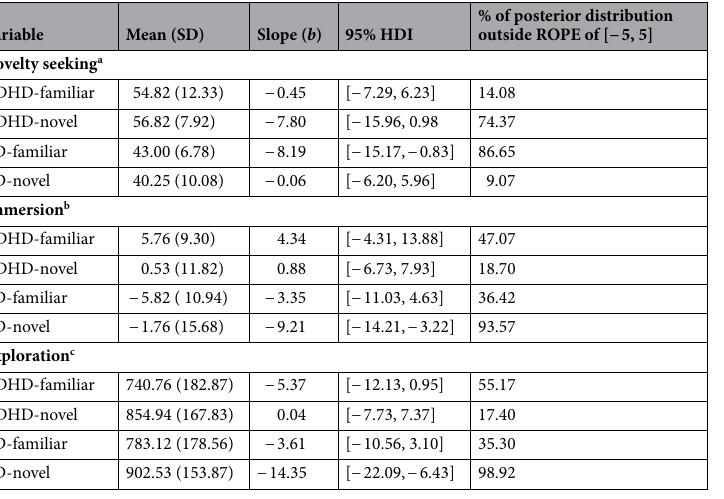
Table 3. Control variables and their influence on memory consolidation. Means and standard deviations (in brackets) for the three control variables, as well as slopes and HDI for the association of control variables and memory retention. The slope indicates the change in memory retention for one standard deviation of the respective control variable. The percentage of the posterior distribution that lies outside the ROPE represents the probability that an effect is significantly different from zero. Values above 95% indicate that an effect can be considered significantly different from zero, while values below 5% indicate that the effect can be considered practically equivalent to zero 65 . HDI highest density interval, ROPE region of practical equivalence, TD